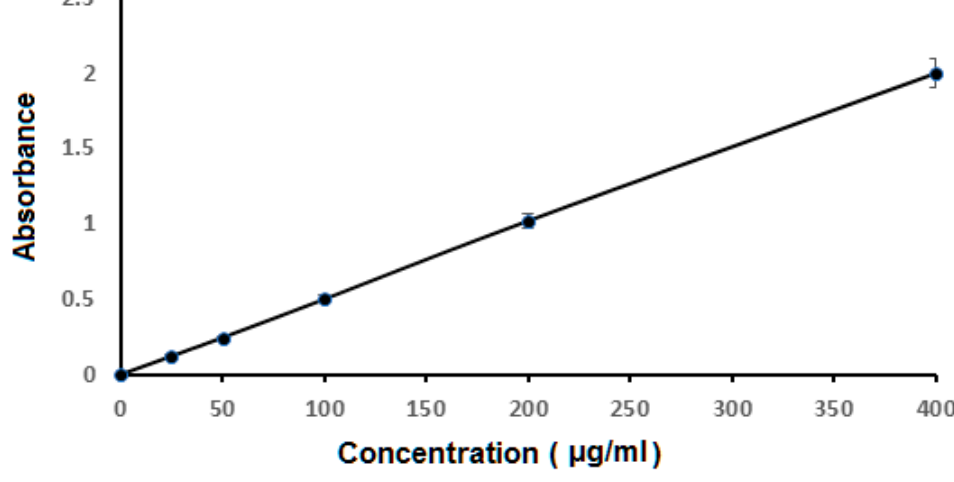
Figure 3. Calibration curve for FLB at 244 nm.